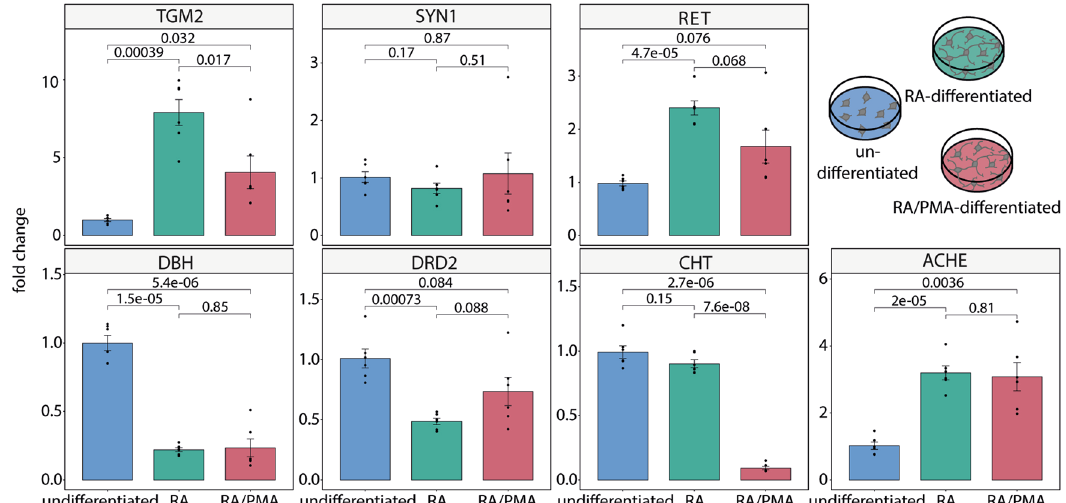
Fig. 4 Relative expression of marker genes to determine neuronal sub-types. qPCR was used to determine the expression of neuronal marker genes ( n = 6). The following marker genes were analysed in undifferentiated (blue), RA-differentiated (green) and RA/PMA-differentiated (red) cells: transglutaminase 2 ( TGM2 ), synapsin 1 ( SYN1 ), ret proto-oncogene ( RET ), dopamine beta hydroxylase ( DBH ), dopamine receptor D2 ( DRD2 ), choline transporter ( CHT ), and acetylcholin esterase ( ACHE ). Speci fi c gene ampli fi cation was normalised to hypoxanthine phosphoribosyl-transferase 1 ( HPRT1 ). The relative expression of the marker genes was calculated as fold- change of the RNA amounts in RA and RA/PMA relative to the RNA amount in undifferentiated cells. The 2 − ΔΔ Ct method was used. Error bars represent the standard error. A two-tailed t -test between two conditions was used for calculation of p -values. Figure generated using Supplementary Data